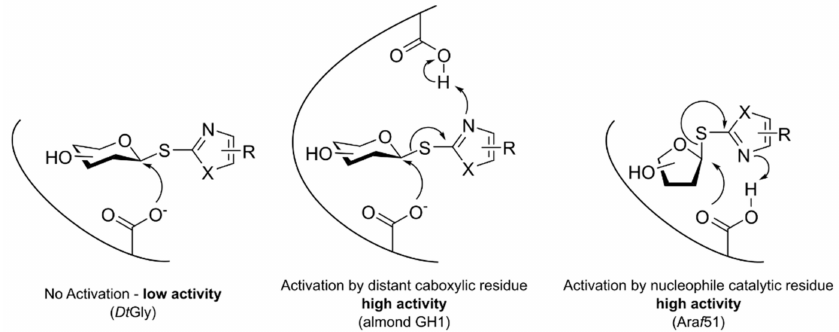
Figure 5. Glycosyl thioimidates require remote activation to promote the leaving group release. Supplementary Materials: The following are available online at http: // www.mdpi.com / 2073-4344 / 9 / 10 / 826 / s1, Figure S1: Model of docked Glc S Box and Glc S Taz in Dt Gly active